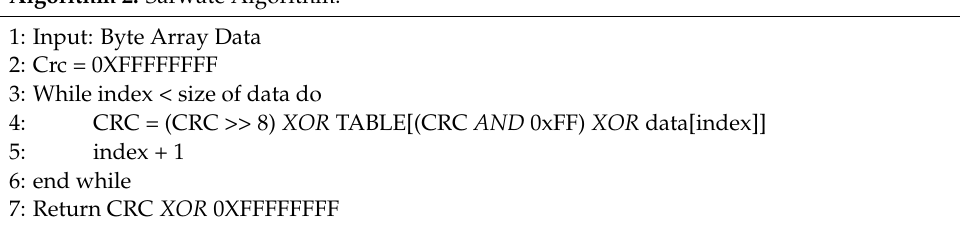
Algorithm 2. Sarwate Algorithm.